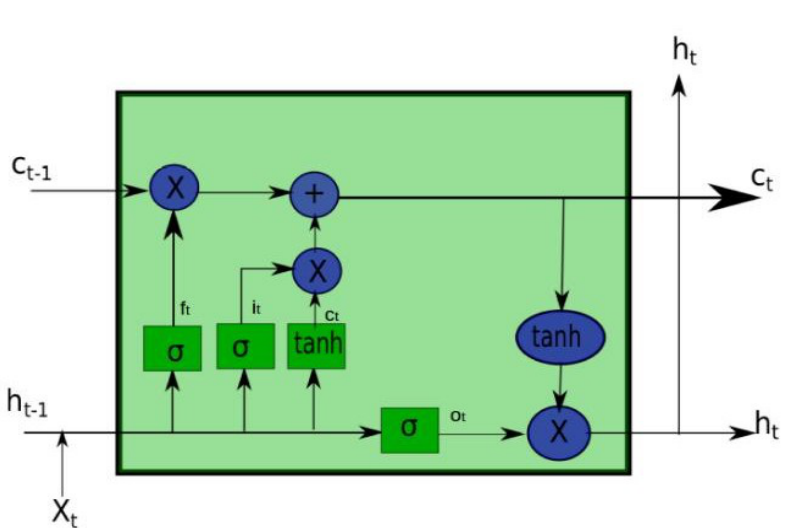
Figure 3. The internal structure of one LSTM